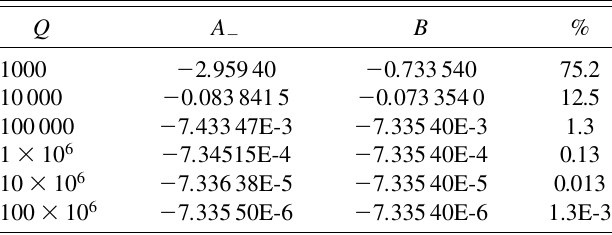
TABLE III. A typical error which one is expected to obtain by using Eq. (21) in estimating the BBU threshold current is computed from an exact expression (A14). The case of a 1889 MHz dipole mode is